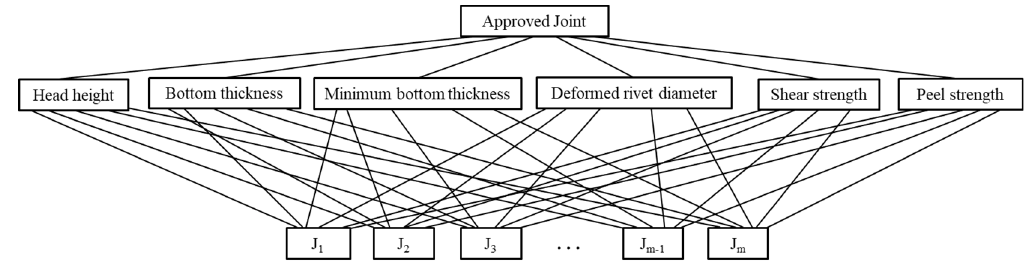
Figure 7. Decision hierarchy structure.